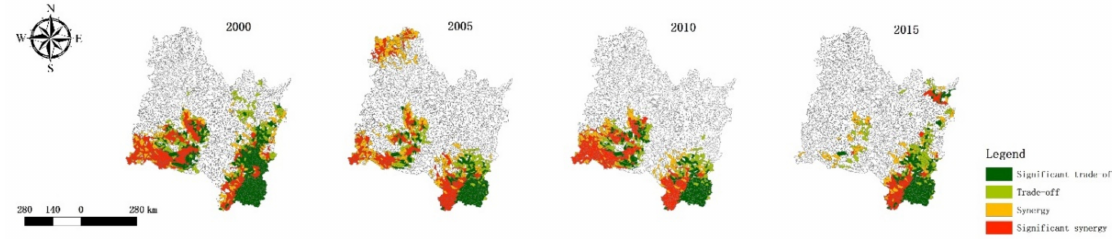
Figure 19. The synergy/trade-off relationship between crop production and carbon